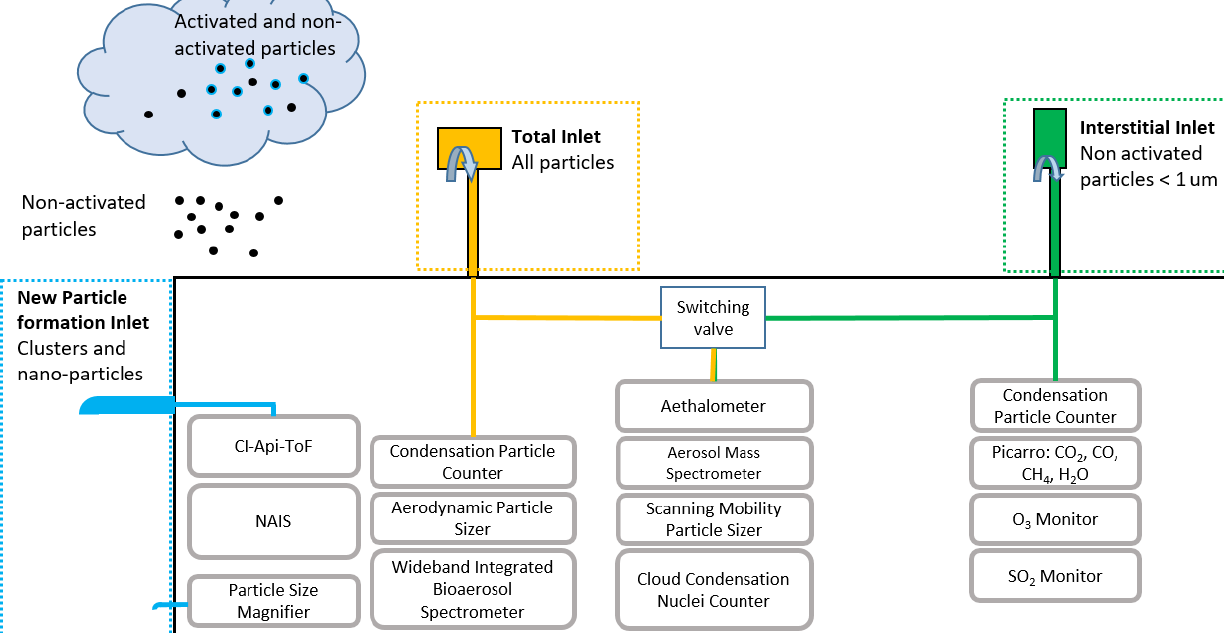
Atmos. Meas. Tech., 15, 4195–4224, 2022